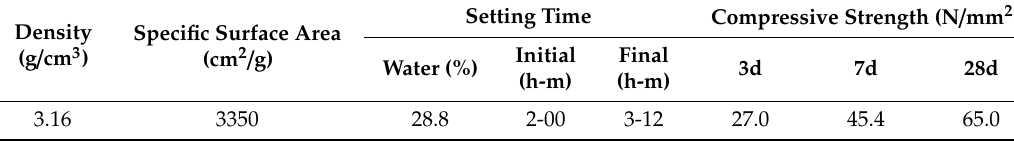
Table 1. Physical properties of ordinary Portland cement.